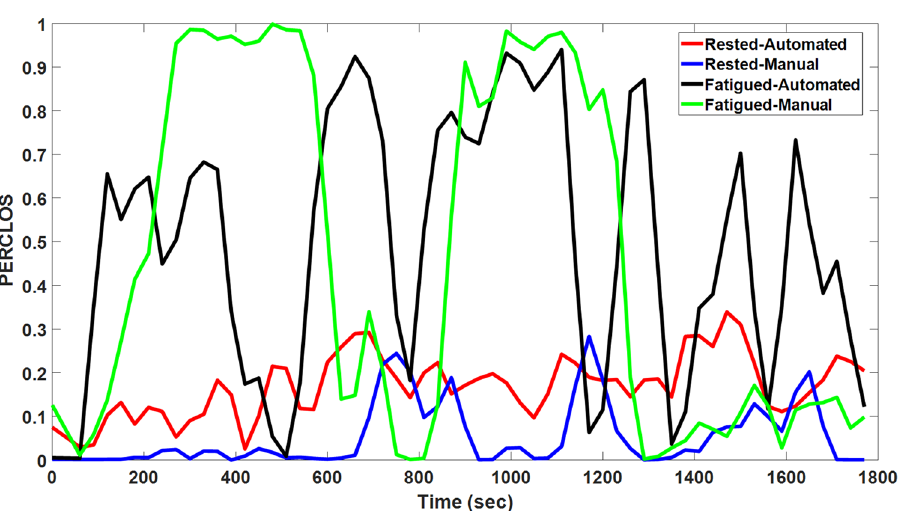
Figure 3. PERCLOS data of four tests in different driving modes: rested-manual, rested-automated, fatigued- manual, and fatigued-automated. A sliding window with a 1-minute length and 30 s overlap between every two adjacent time windows has been used to compute PERCLOS from the eyelid